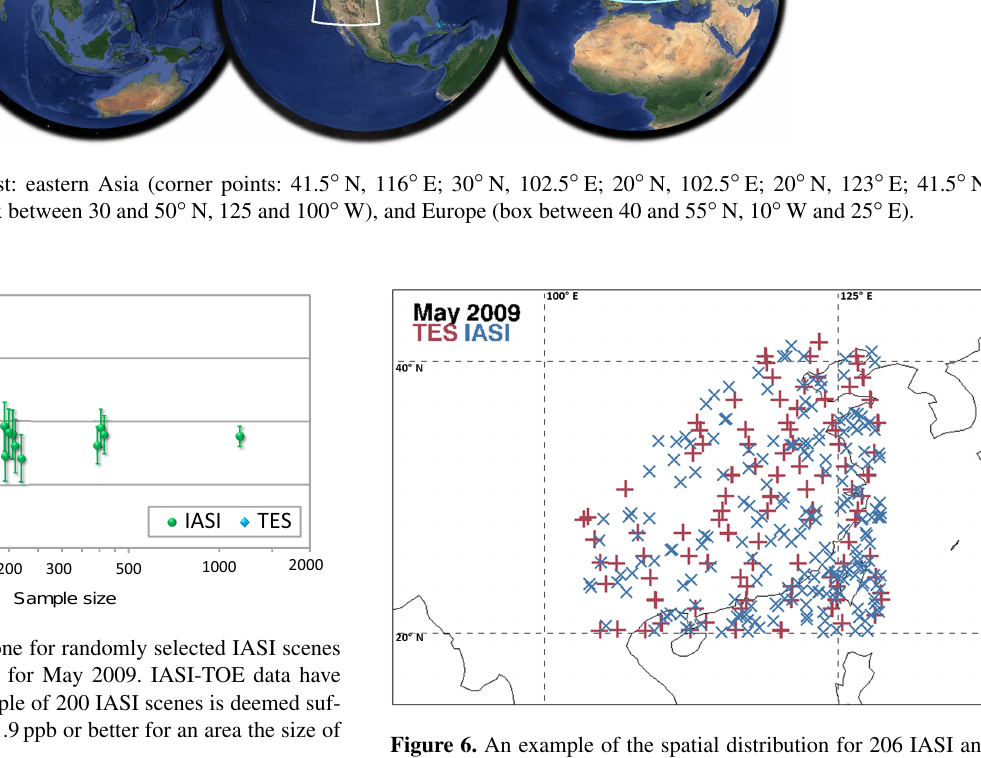
Figure 6. An example of the spatial distribution for 206 IASI and 128 TES data